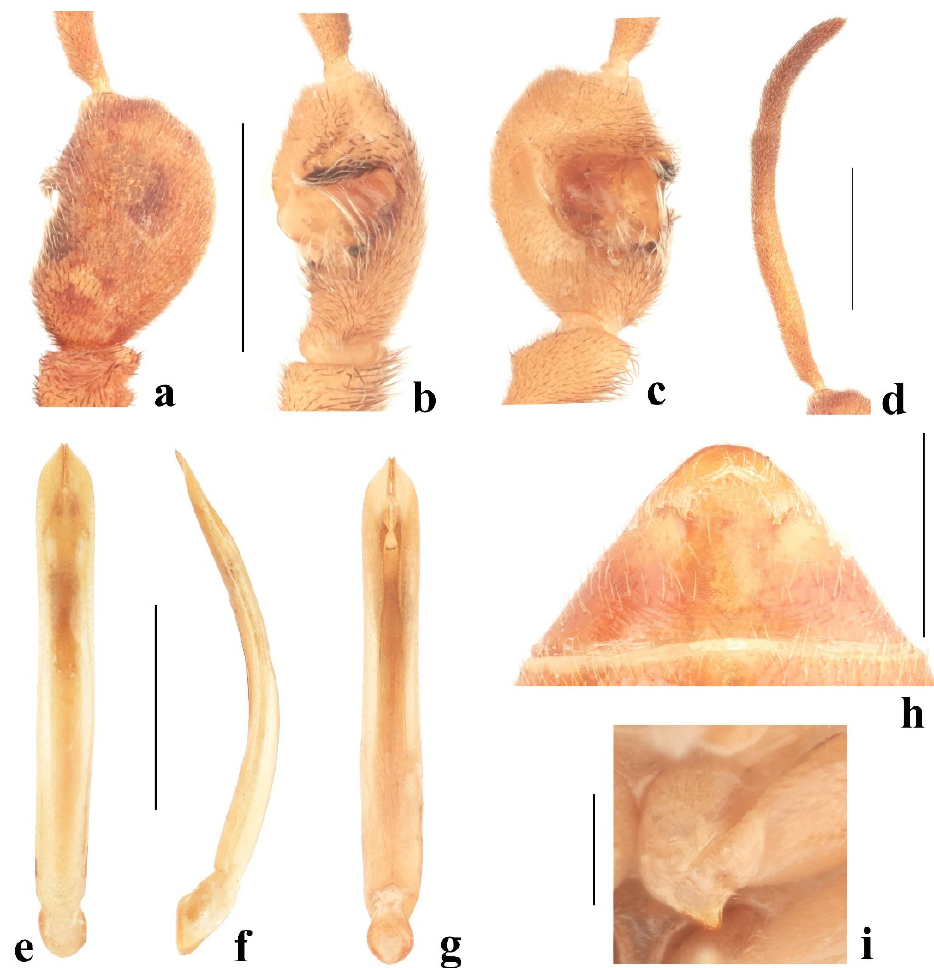
Figure 13. Taumacera adamskii sp. nov., holotype: ( a ) antennomere X, dorsal view; ( b ) antennomere X, lateral view; ( c ) antennomere X, ventral view; ( d ) antennomeres XI–XII; ( e ) aedeagus, dorsal view; ( f ) aedeagus, lateral view; ( g ) aedeagus, ventral view; ( h ) last abdominal ventrite; ( i ) procoxa. (Scale bars: ( a – h ) = 1 mm, ( i ) = 0.5 mm).